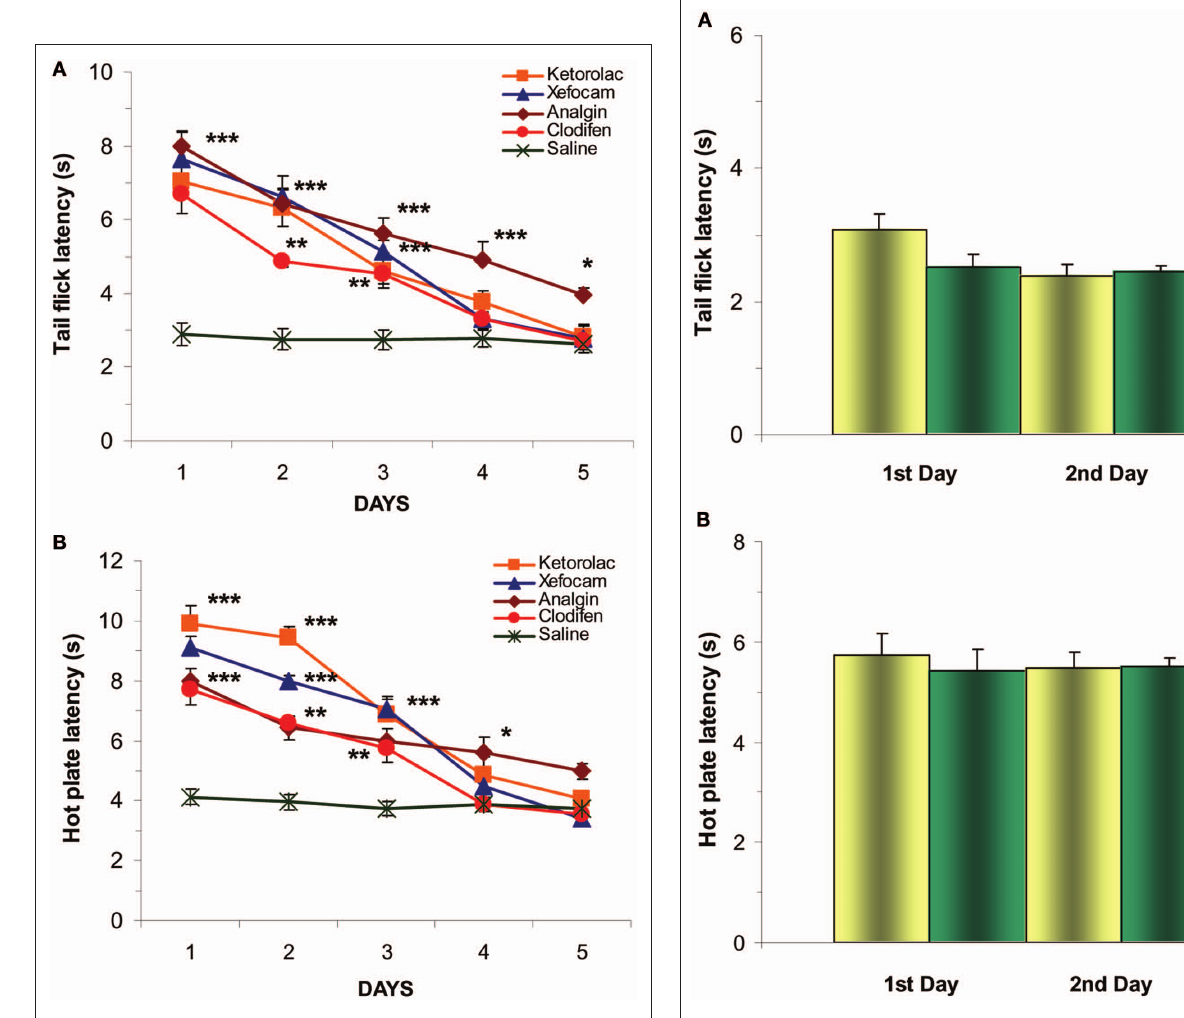
Figure 3 | Control experiments of post-treatment with naloxone after microinjections of saline into NrM does not significantly change TF (A) and HP (B) latencies either for the first or second days. N = 4 per